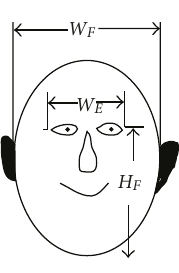
Figure 2: Rectangular boundary defining the face region.